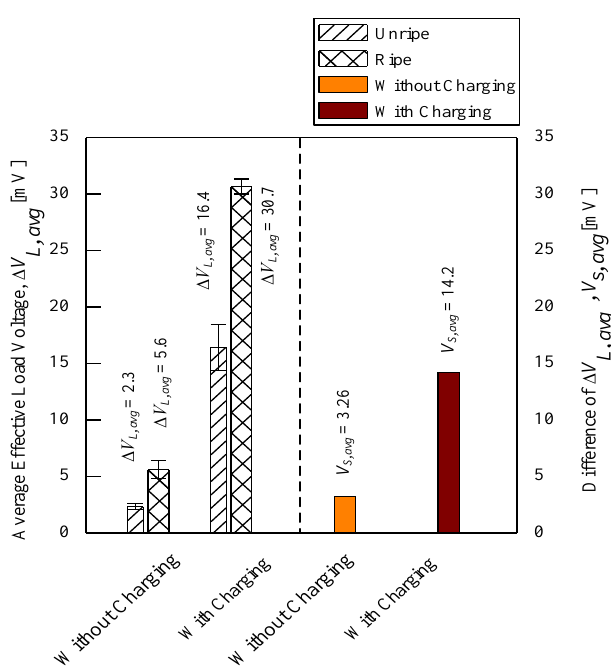
Figure 7. Load resistance voltage characteristics of fruit battery with and without charging process.